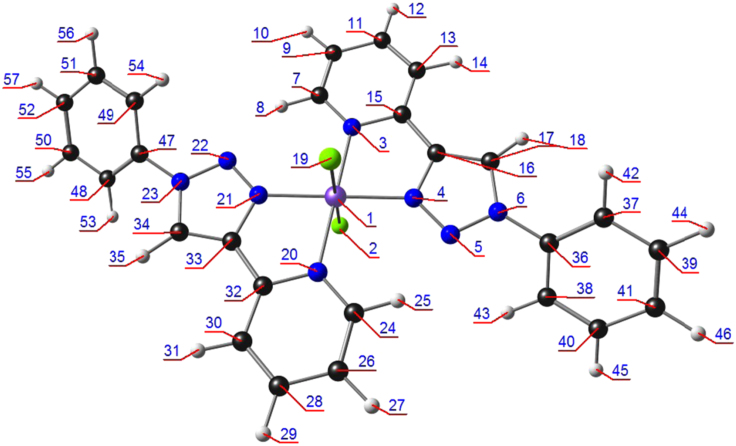
Atom numbering of dichloro{bis[2-(1-phenyl-1H-1,2,3-triazol-4-yl-κN3]pyridine-κN]}iron(II), [FeII(L8)2Cl2] used in Tables 2, 3, and 5. Colour code of atoms (online version): Fe (purple), Cl (green), N (blue), C (black), H (white).